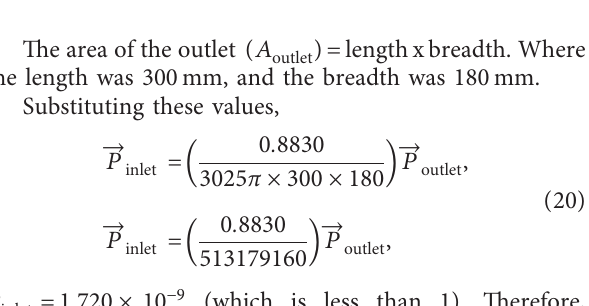
Figure 5: Inlet and outlet chambers based on the